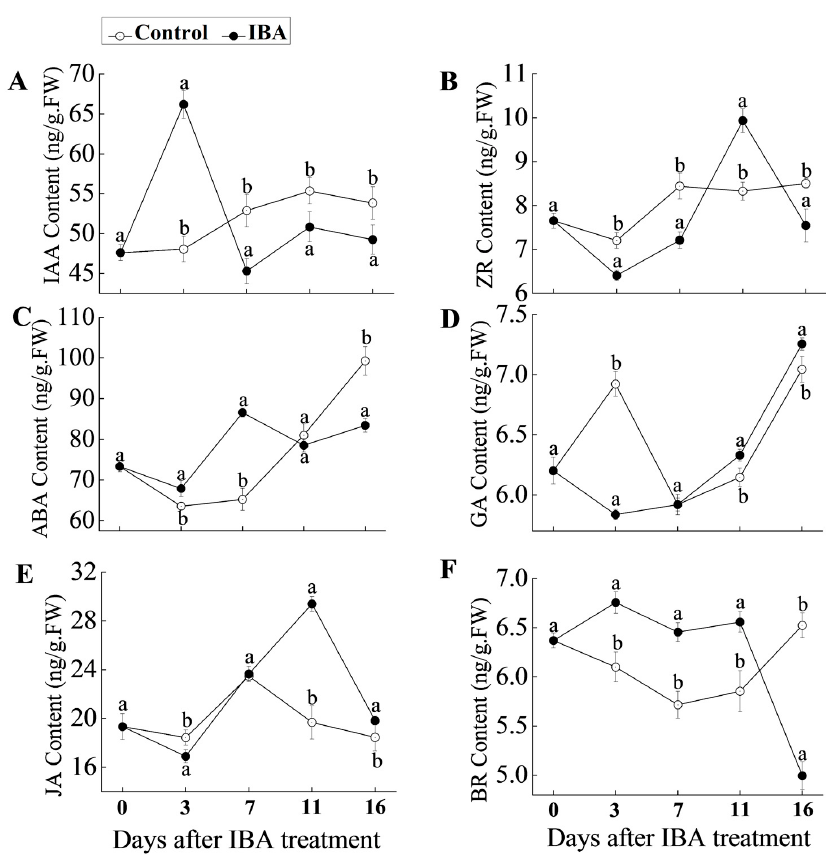
Figure 2. Endogenous hormone levels in ‘T337’ basal cuttings after treatment with IBA and control for 0, 3, 7, 11, 16 days. ( A ) Auxin (IAA) content; ( B ) Zeatin riboside (ZR) content; ( C ) Abscisic acid (ABA) content; ( D ) Gibberellins (GA) content; ( E ) Jasmonic acid (JA) content; and, ( F ) Brassinolide (BR) content. Statistically significant differences in IBA-treated cuttings and control on each day are